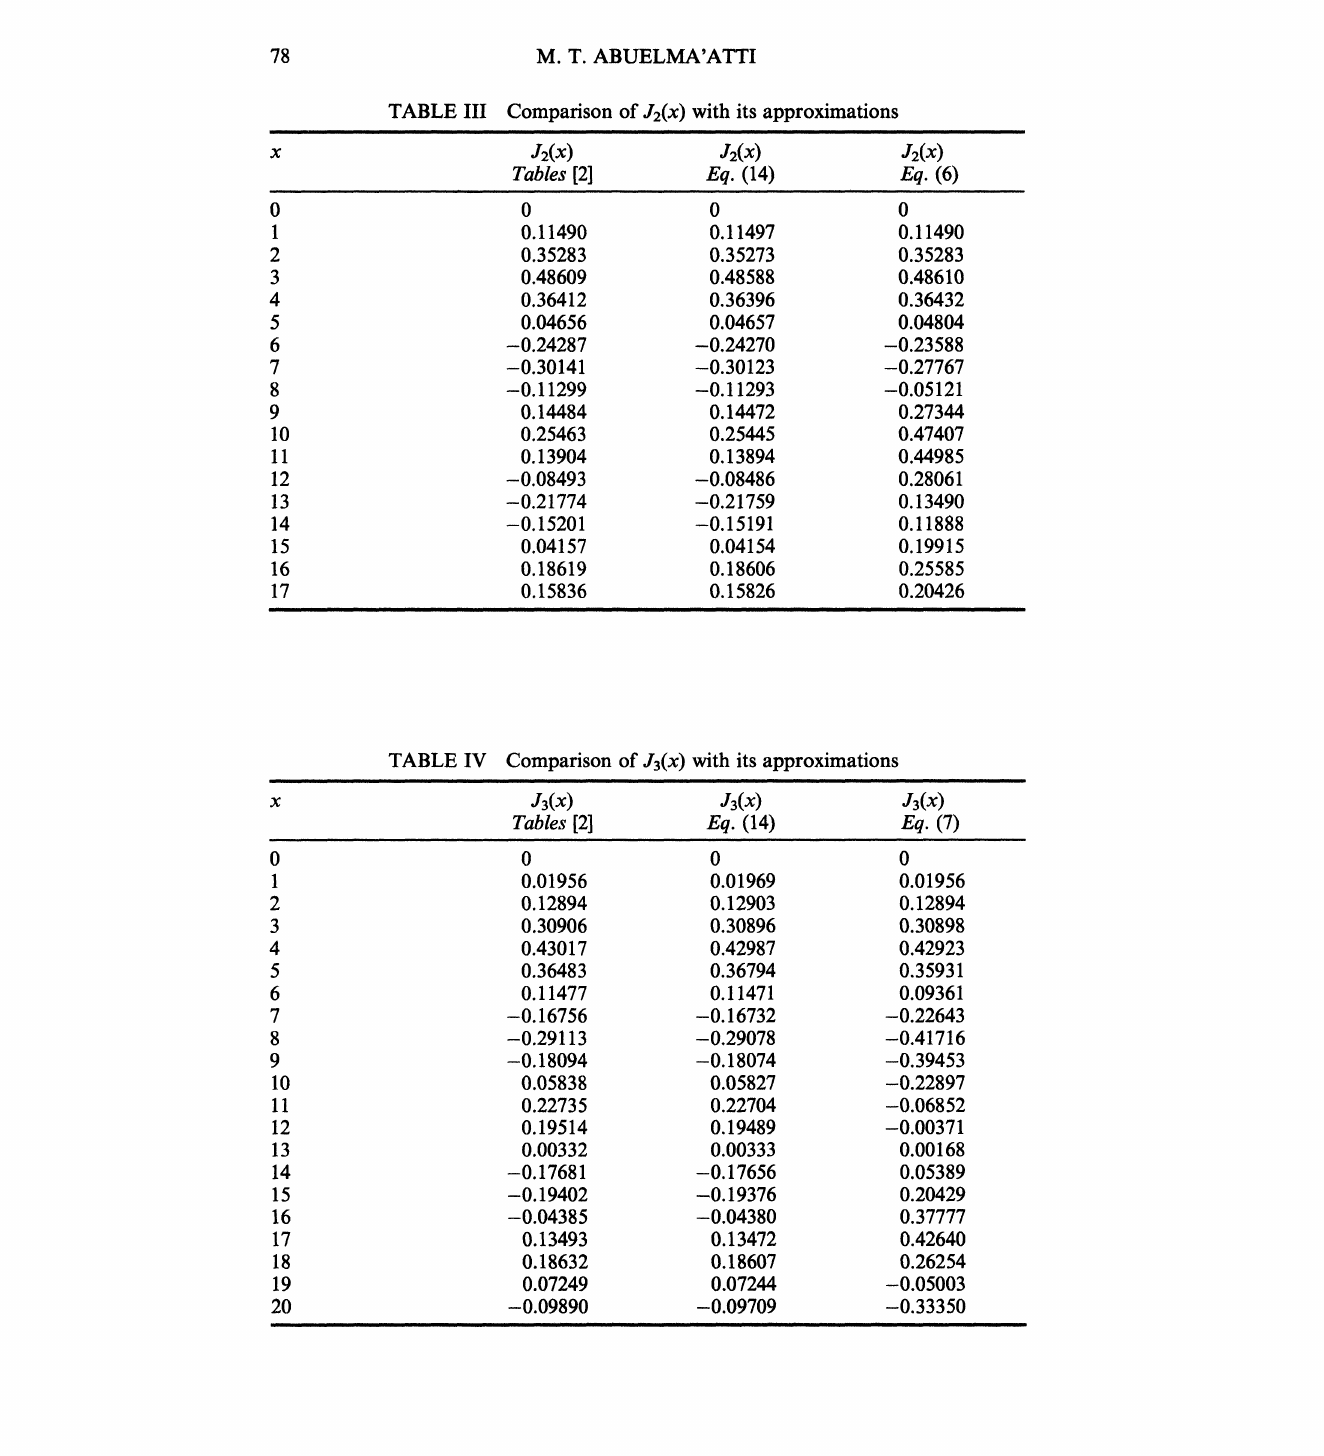
TABLE III Comparison of J2(x) with its approximations